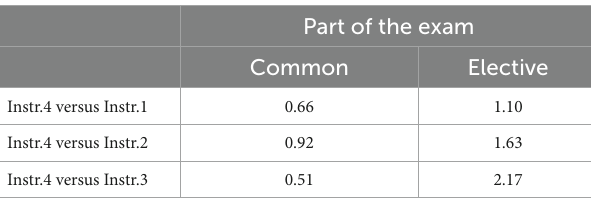
TABLE 4 Comparing cognitive demand of the four exams (Cohen’s d